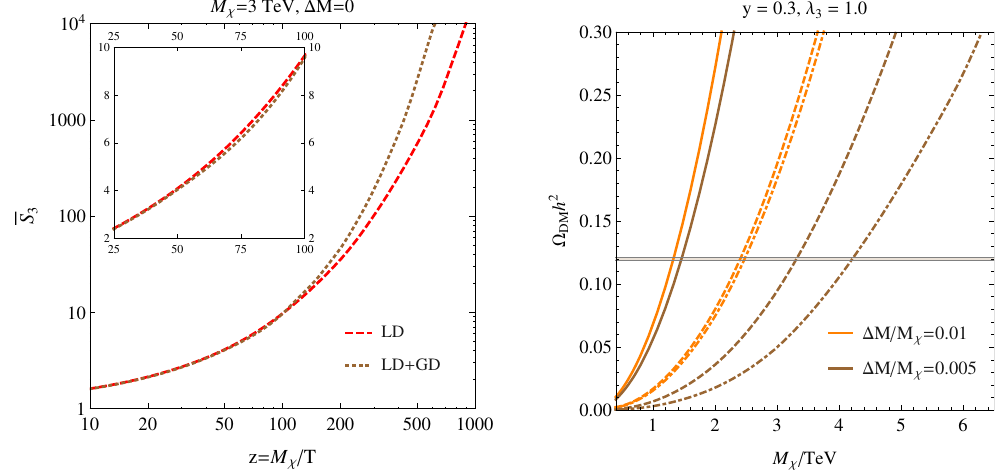
Figure 2 . (Left plot) The generalized Sommerfeld factor (cid:22) S 3 corresponding to the annihilation of the coloured scalars via the singlet channel. The red-dashed lines correspond to the case where only the Landau damping and Debye screening is included, whereas in the brown-dotted line we include the e(cid:11)ect of gluo-dissociation/radiative emission. (Right plot) The DM abundance at z (cid:12)n = 10 3 where the horizontal gray band shows the observed value (cid:10) = 0 : 1200(12) [24]. The couplings DM are (cid:12)xed to y = 0 : 3 and (cid:21) 3 = 1 : 0 and we show the result for (cid:1) M=M (cid:31) = 0 : 01 and (cid:1) M=M (cid:31) = 0 : 005. The solid lines shows the free (without gluon exchange) result for the selected (cid:1) M=M (cid:31) values, whereas dashed and dot-dashed are obtained with the generalized Sommerfeld